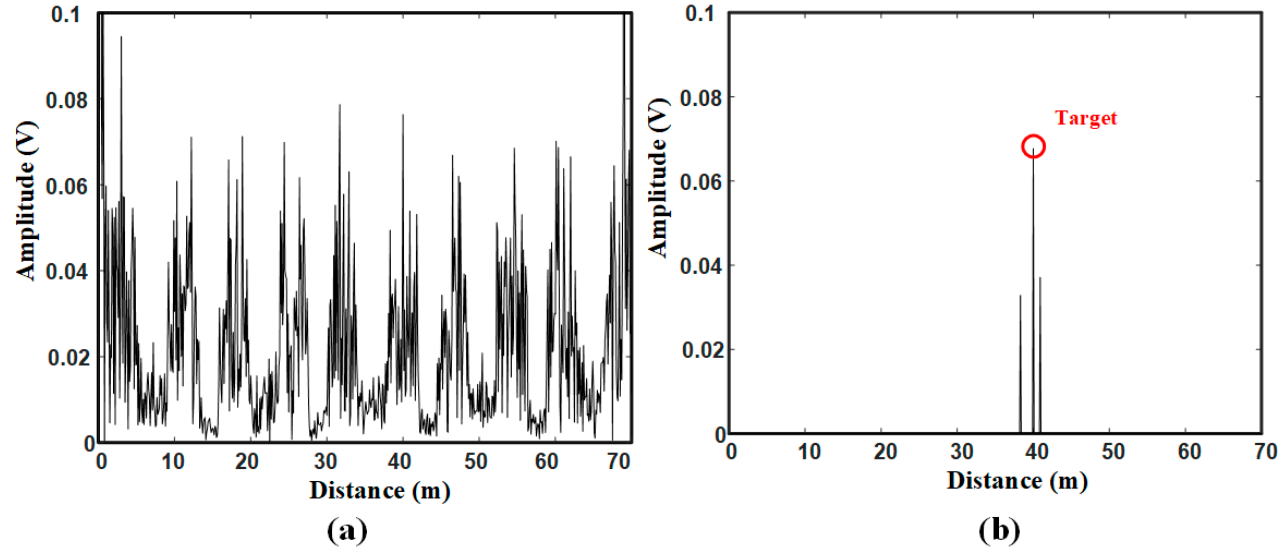
Figure 13. Signals in scene 1: ( a ) Original signal; ( b ) Target detection result.